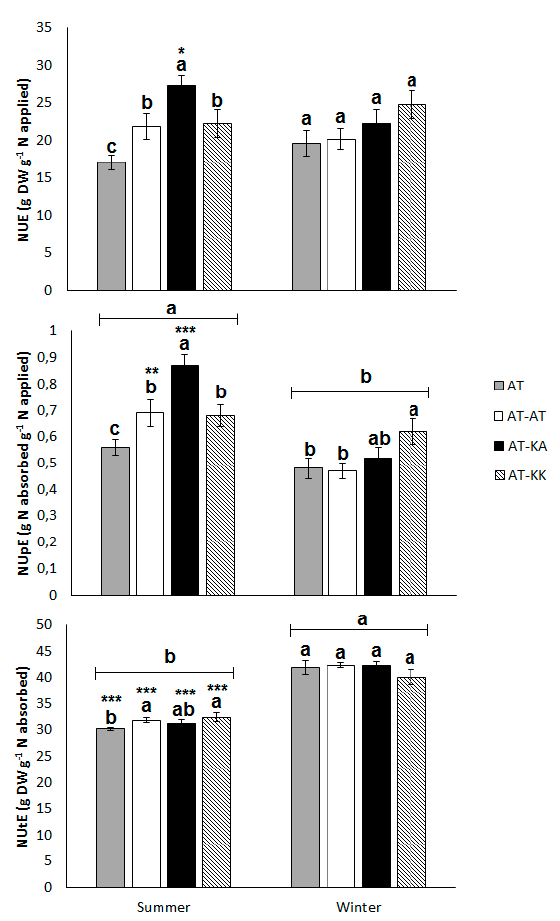
Figure 3. Nitrogen-use (NUE; top), -uptake (NUpE; middle), and, -utilization e ffi ciency (NUtE; bottom) for each treatment during summer or winter season. Bars represent means ± s.e. of twelve replicates. Di ff erent letters on top of the bars denote significant di ff erences ( p < 0.05) among treatments under the same growing season. Asterisks denote significant di ff erences (*: p < 0.05; **: p < 0.01; and, ***: p < 0.0001) in the same treatment between seasons. (a, b) Letters above light groups denote significant di ff erences ( p < 0.05) between light levels.